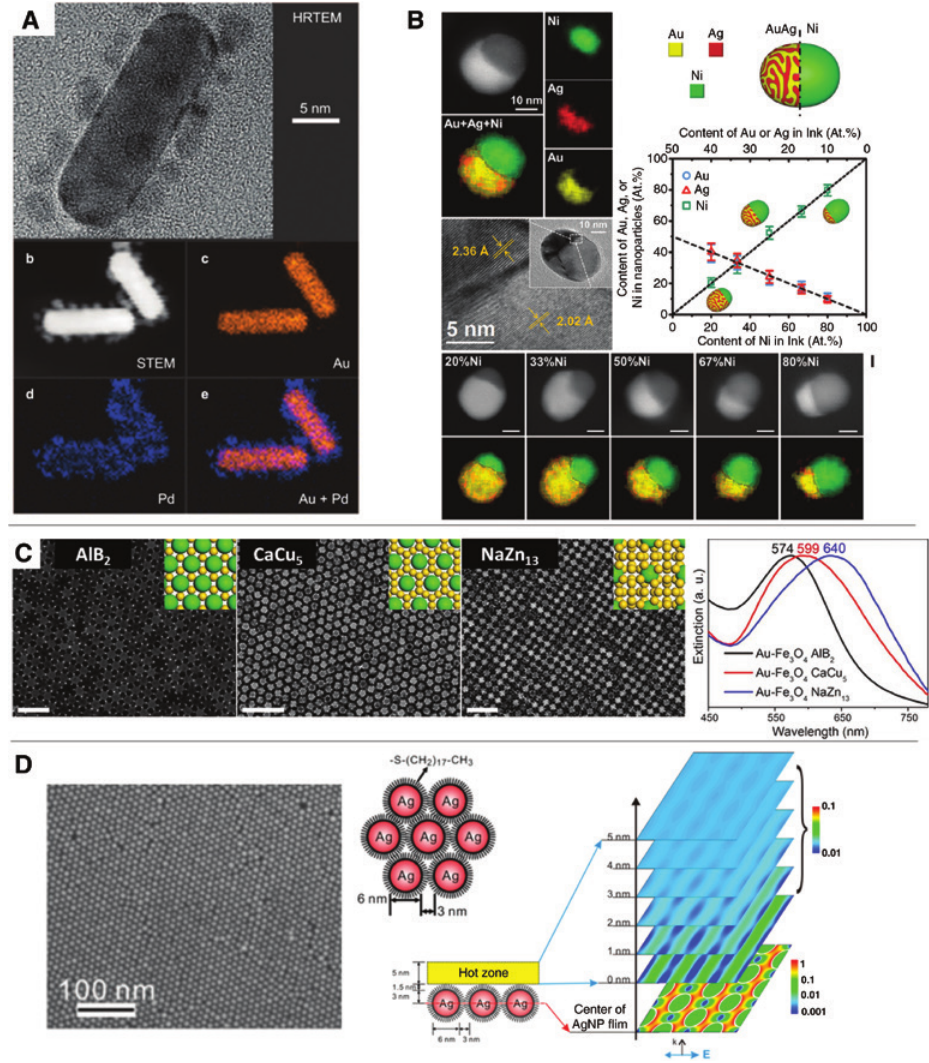
Figure 3: Functional combinations of plasmonic materials. (A) High-resolution TEM image of sub-5-nm Pd nanoparticles after DNA-assisted assembly on a Au nanorod. The four panels below show scanning TEM (STEM) and element-resolved (energy-filtered) STEM images to represent the material distribution. This complex is used to sense hydrogen. Adapted from [50]. (B) Polyelemental AuAgNi heterostructured nanoparticles generated by scanning probe block copoly- mer lithography. There are different TEM micrographs, high-angle annular dark-field scanning TEM images, and energy-dispersive X-ray spectroscopy elemental mapping of AuAgNi nanoparticles with tailorable composition. The illustration shows a representative AuAgNi par- ticle (24% Au, 24% Ag, and 52% Ni). Au and Ag are miscible and both elements are immiscible once Ni is added, resulting in a heterodimer. Adapted from [51]. (C) TEM images of binary superlattices assembled from 9.7-nm Au nanoparticles and 17.1-nm or 14.1-nm Fe cles. The crystallisation into AlB , CaCu , and NaZn -type superlattices determines particle spacing and plasmon coupling. The graph shows 2 5 13 extinction spectra of superlattices on the left. Adapted from [52]. (D) Field-emission SEM image of a superlattice of 6-nm Ag nanoparticles used as a homogenous single-molecule SERS substrate. Illustrations of assembly, the SERS detection hot zone, and finite-difference time- domain simulated field patterns are present. Adapted from